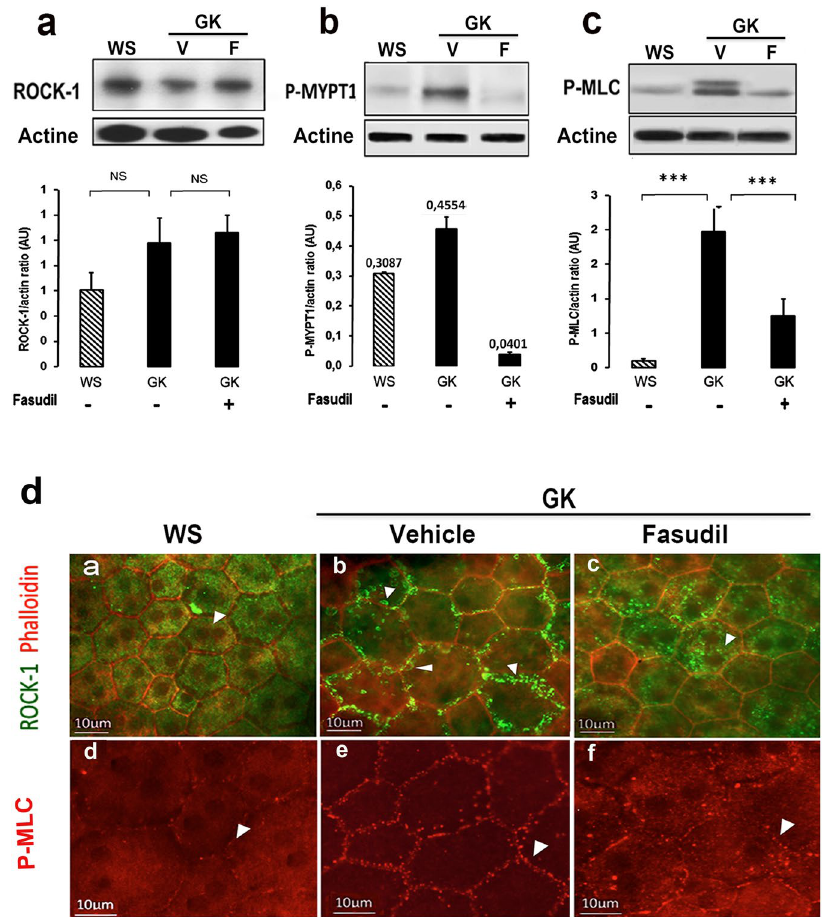
Figure 4. Effect of intravitreal fasudil on ROCK-1 activation state. Western blotting analyses to assess ROCK-1 protein level showed no significant change in any group with Fasudil treatment in GK rats as compared to vehicle treated GK rats (V) or WS rats (n = 6–7 per group) ( a ). An in vitro ROCK activity immunoblot kit evaluating recombinant MYPT1 phosphorylation level was performed and showed a decrease in ROCK activity in GK Fasudil treated rats ( b ) (n = 5 per group). We confirmed ROCK-1 activity inhibition by the significant decrease of MLC phosphorylation in GK Fasudil treated rats ( c ) (n = 12 per group); *** p value < 0.001. In GK rats, activation of ROCK-1 coincides its membrane recruitment and associated with P-MLC at the membrane ( D ,b,e). Fasudil restores the cytoplasmic localization of ROCK-1 and MLC ( D